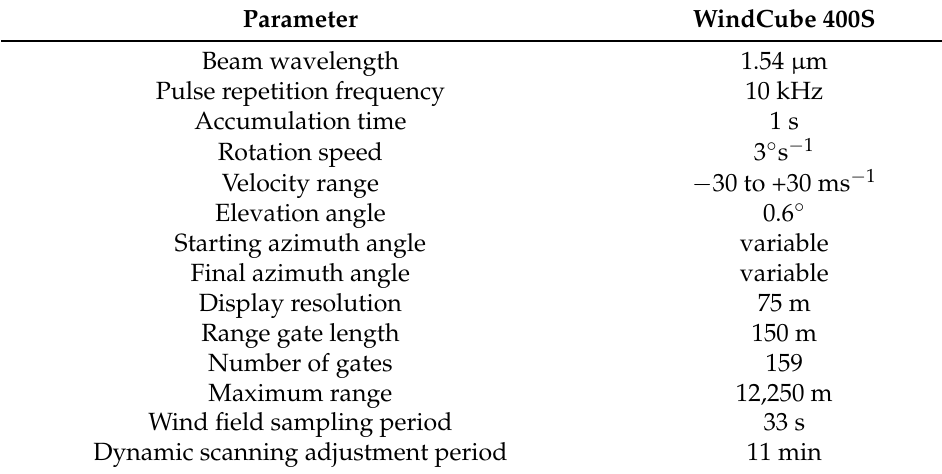
Table 1. LiDAR scan